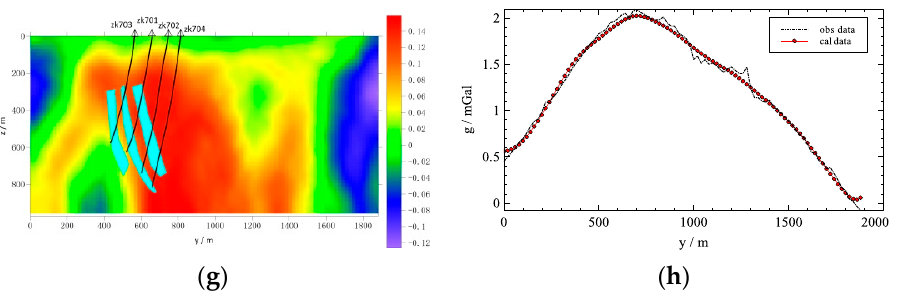
Figure 9. The Lp-norm inversion results of abnormal gravity field in the Shihe area. ( a , c , e , g ) are the results while 𝑝 = 1 , 𝑝 = 1.1 , 𝑝 = 1.5 and 𝑝 = 2, respectively; the line denotes the drill-hole, the cyan block denotes the ore body, and ( b , d , f , h ) are the corresponding data fit lines.